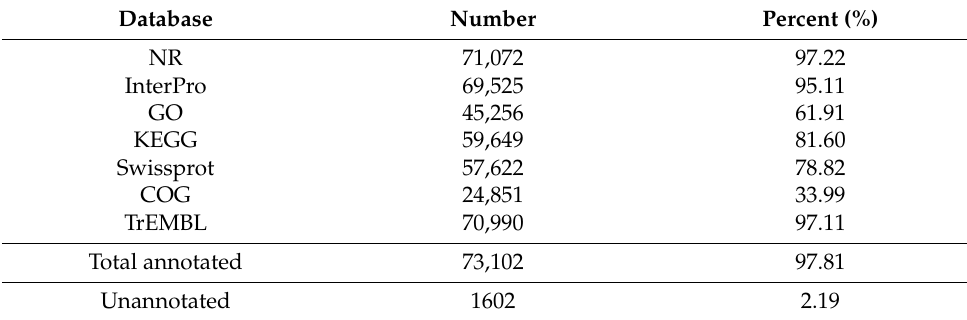
Table 6. Statistics of function annotation.